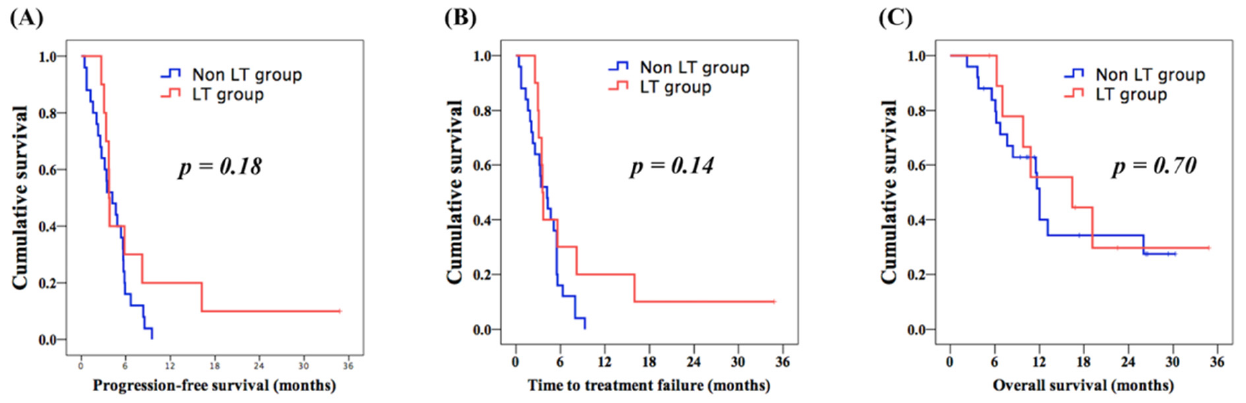
Figure 2. Comparison of Kaplan–Meier survival curves of progression-free survival (PFS), time to treatment failure (TTF) and overall survival (OS) between liver transplantation (LT) group and non-LT group. ( A ) PFS, ( B ) TTF and ( C ) OS.